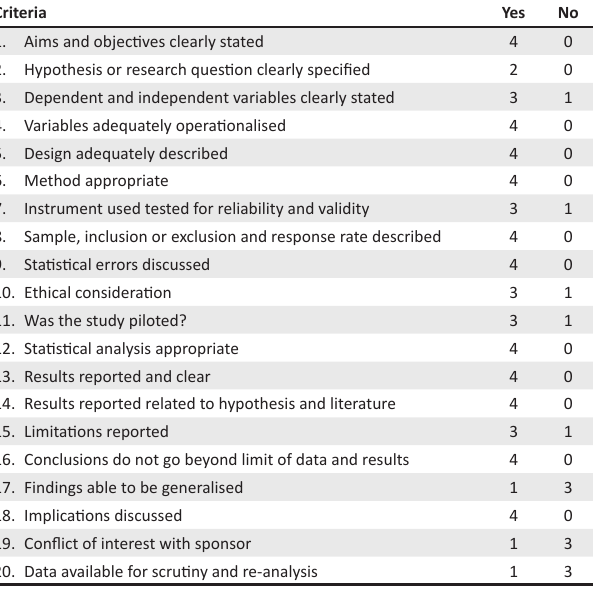
TABLE 3: Quantitative studies critical appraisal checklist. Criteria Yes No